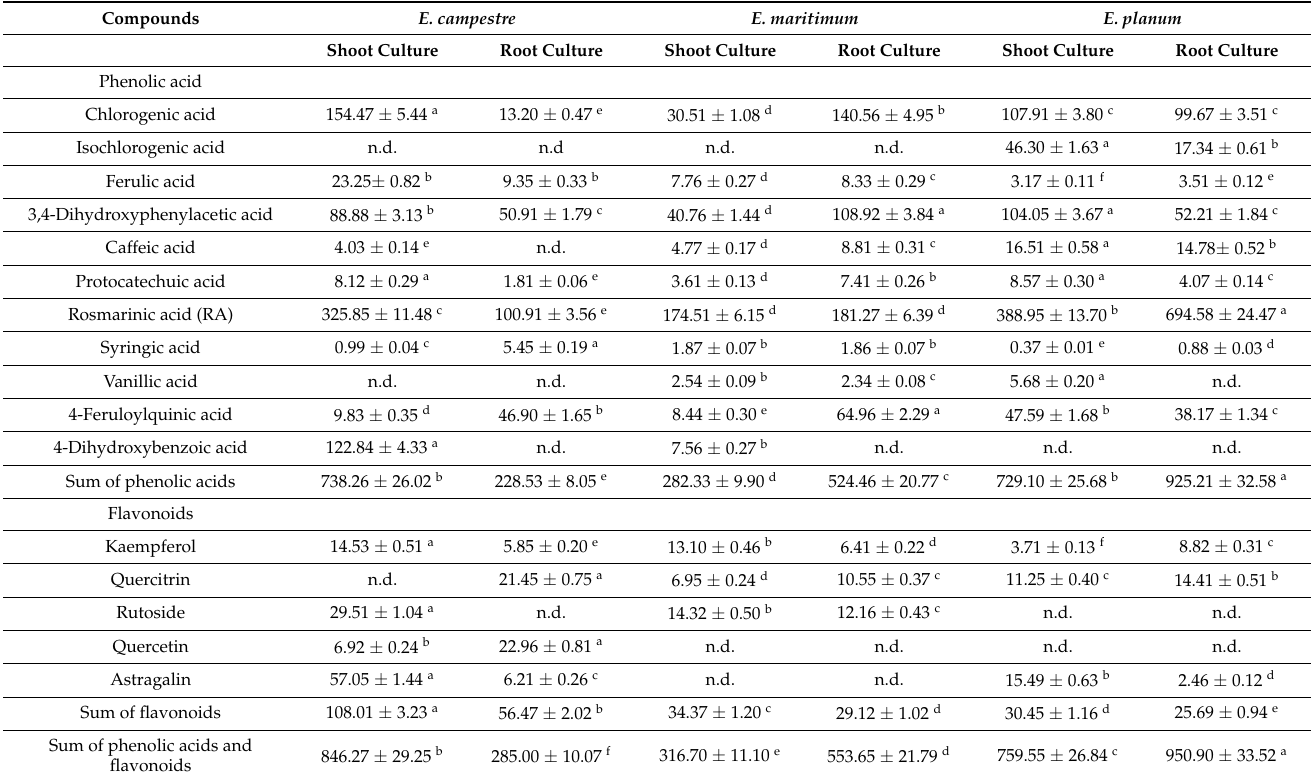
(Table 3). Comparing the total contents of flavonoids in in vitro cultures of analogous organs of Eryngium spp., a trend according to the formula can be noticed: E.